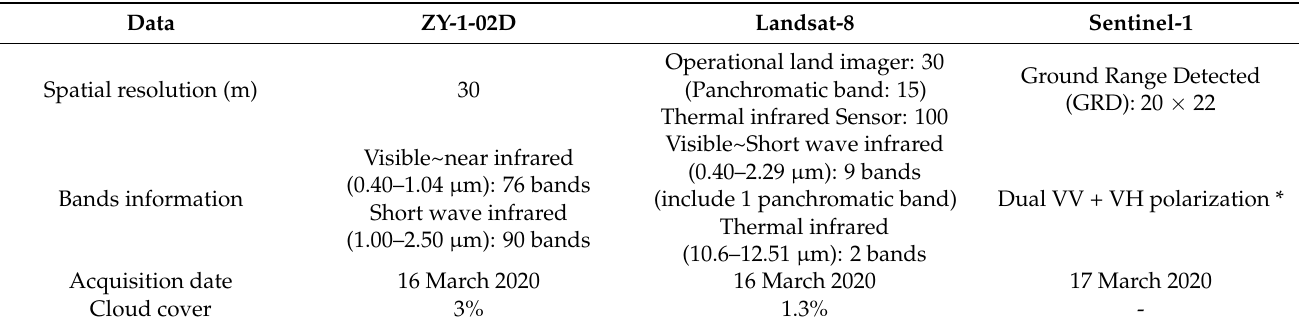
Table 1. Characteristics of satellite images.